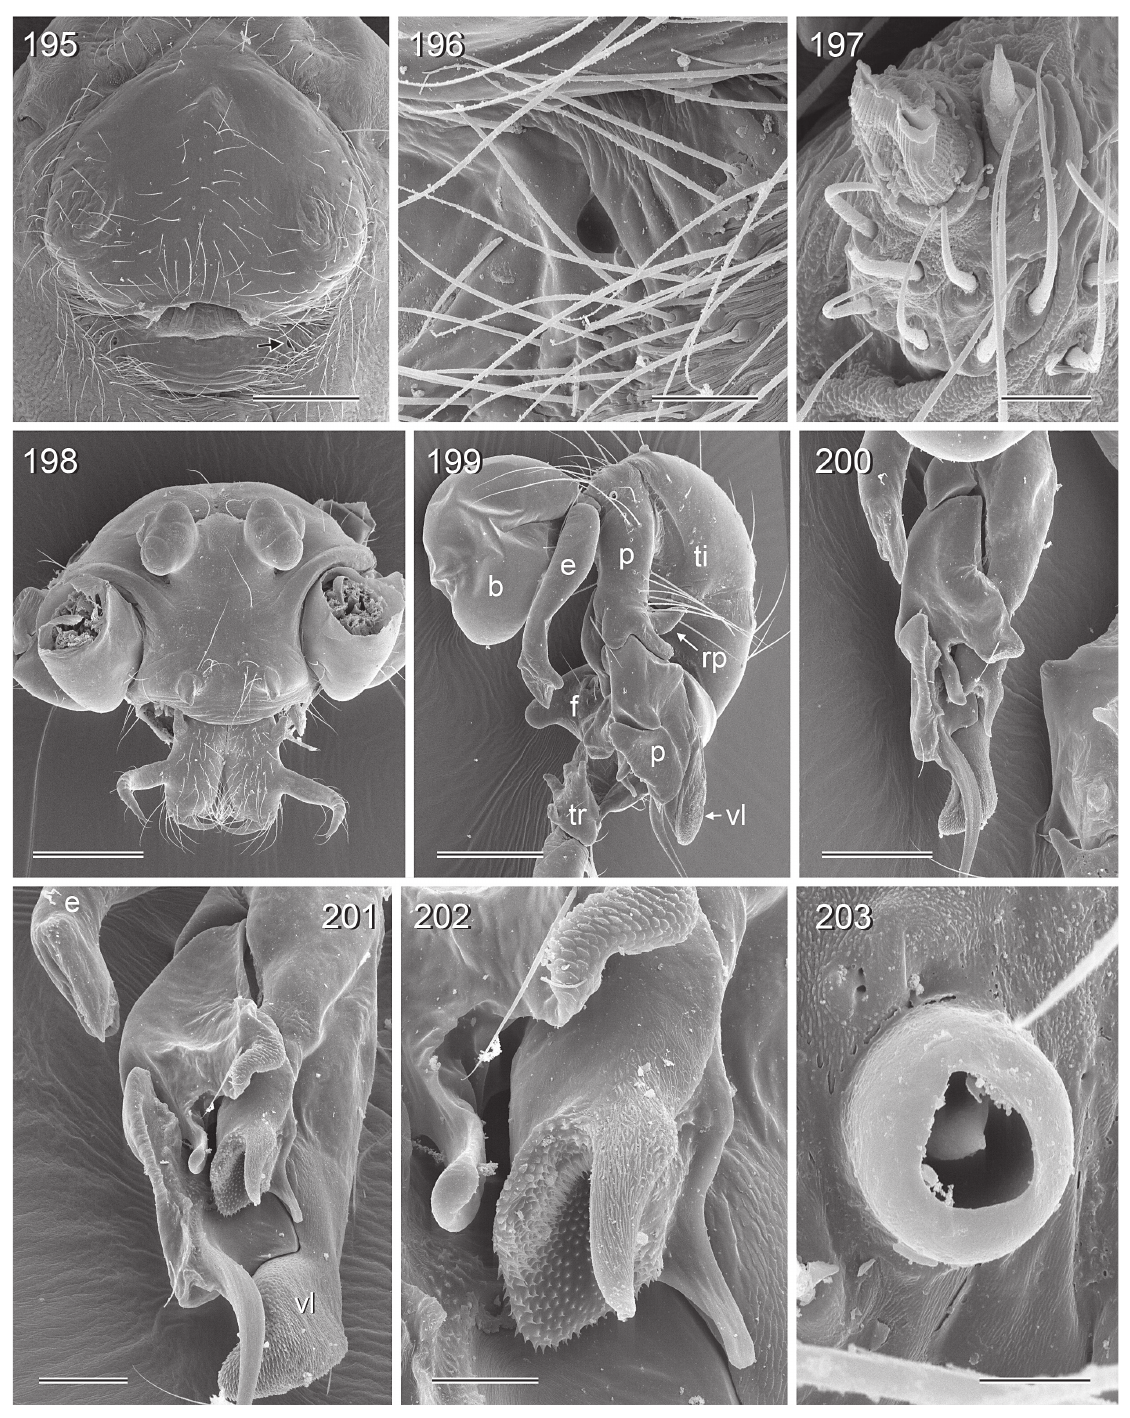
Figs 195–203. — 195–197 . Aetana abadae Huber, sp. nov. 195. Epigynum, ventral view. 196. Detail of preceding, showing opening of membranous pocket (arrow on Fig. 195). 197. Female ALS. — 198–203 . A. omayan Huber, 2005. 198. Male prosoma, frontal view. 199. Left palp, retrolateral view. 200–201. Right procursus, prolatero-dorsal and prolateral views. 202. Detail of preceding. 203. Male palpal tarsal organ. b = genital bulb; e = embolus; f = femur; p = procursus; rp = retrolatero-ventral process; ti = tibia; tr = trochanter; vl = ventral lamina. Scale lines: 195, 199 = 300 µm; 196, 202 = 40 µm; 197, 203 = 10 µm; 198 = 500 µm; 200 = 200 µm; 201 =